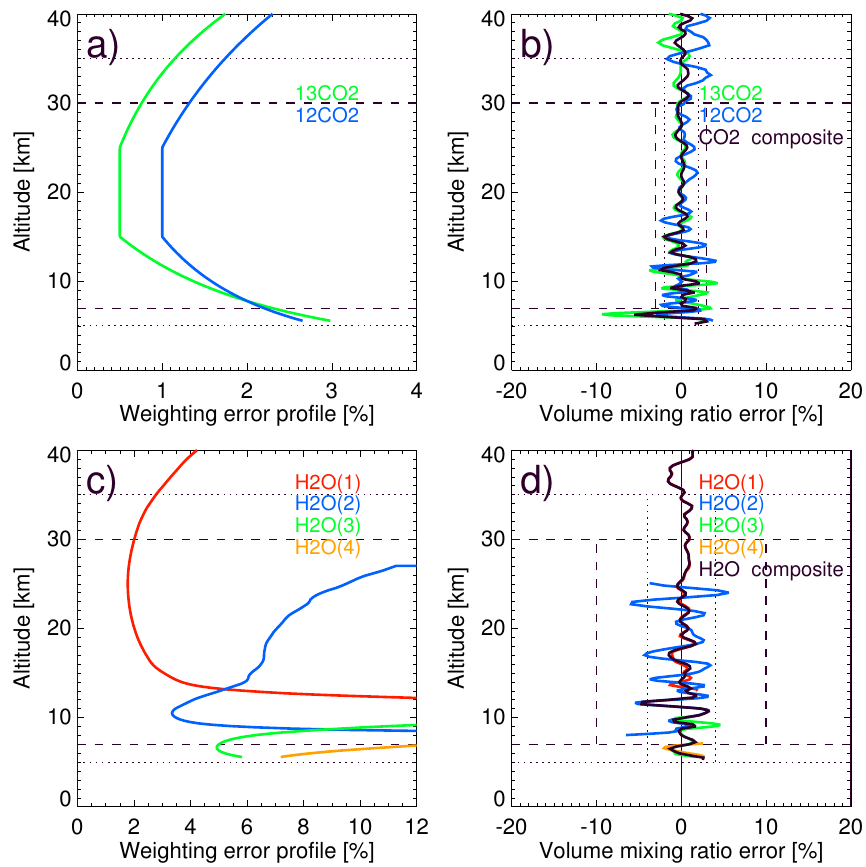
Fig. 7. Ilustration of combining the 12 CO 2 and 13 CO 2 VMR profiles into a composite CO 2 profile (top panels), and of the four H 2 O( X ) ( X = { 1, 2, 3, 4 } ) VMR profiles into a composite H 2 O profile (bottom panels). The left panels (a, c) show the weighting error profiles used within the respective weighting functions for inverse-variance-weighted combination of the profiles (different color per single-line species). The right panels (b, d) show the VMR retrieval error results of the individual single-line species (colored lines) overplotted by the error of the composite profile (black